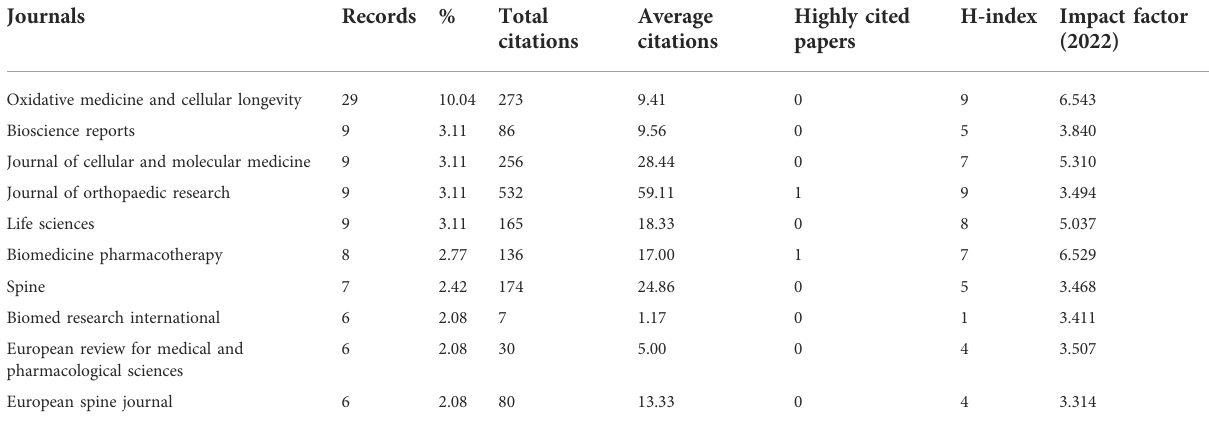
TABLE 5 Top 10 journals with the most publications on oxidative stress in intervertebral disc degeneration from 2007 to 2021.